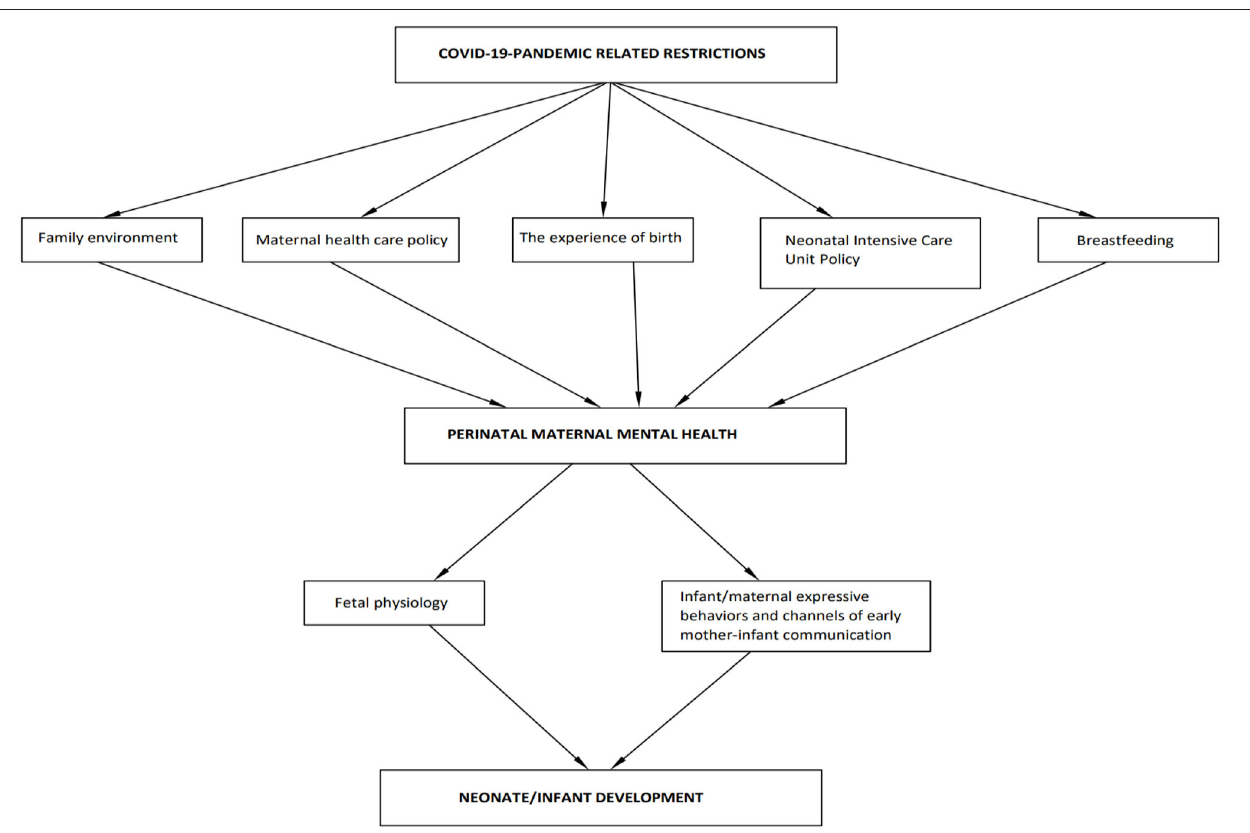
FIGURE 1 | Factors that may affect perinatal maternal mental health through pandemic-related restrictions and implications for neonate and infant